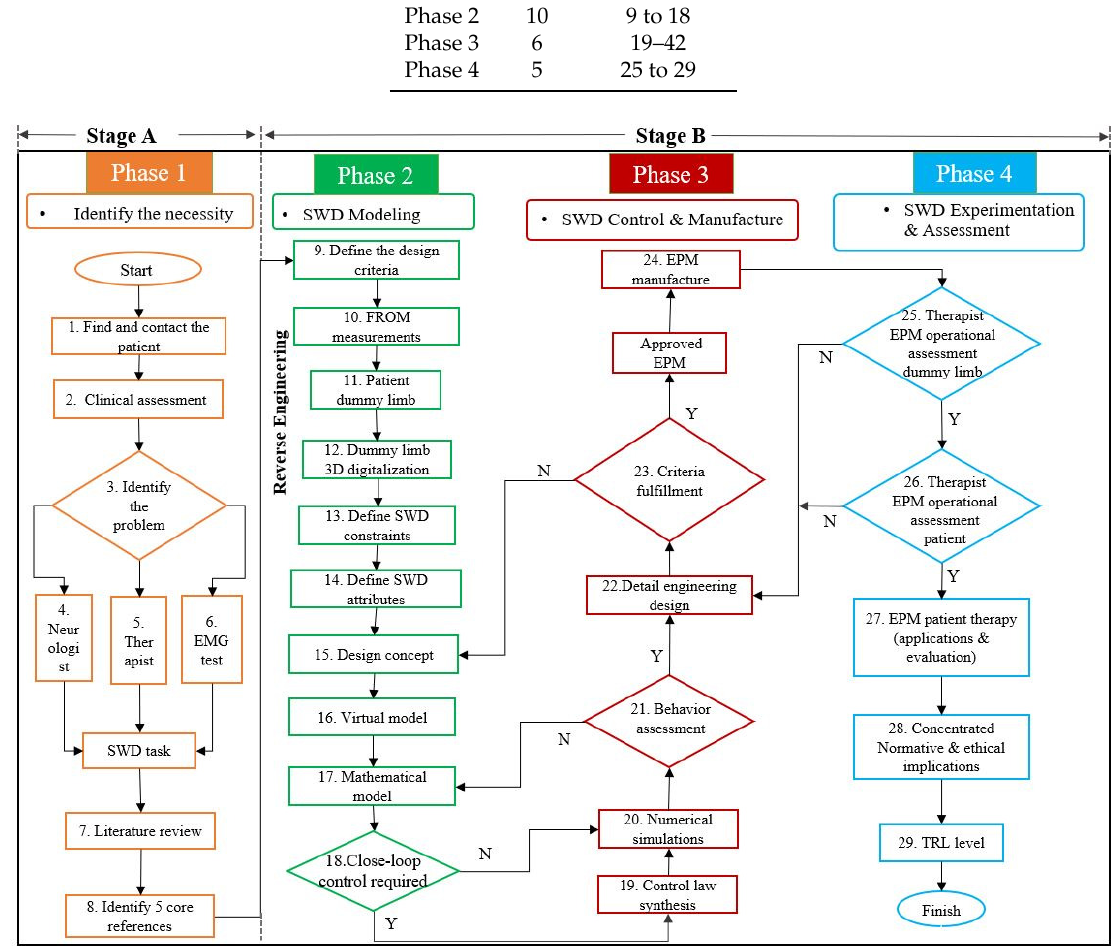
Figure 2. Flowchart of soft wearable devices